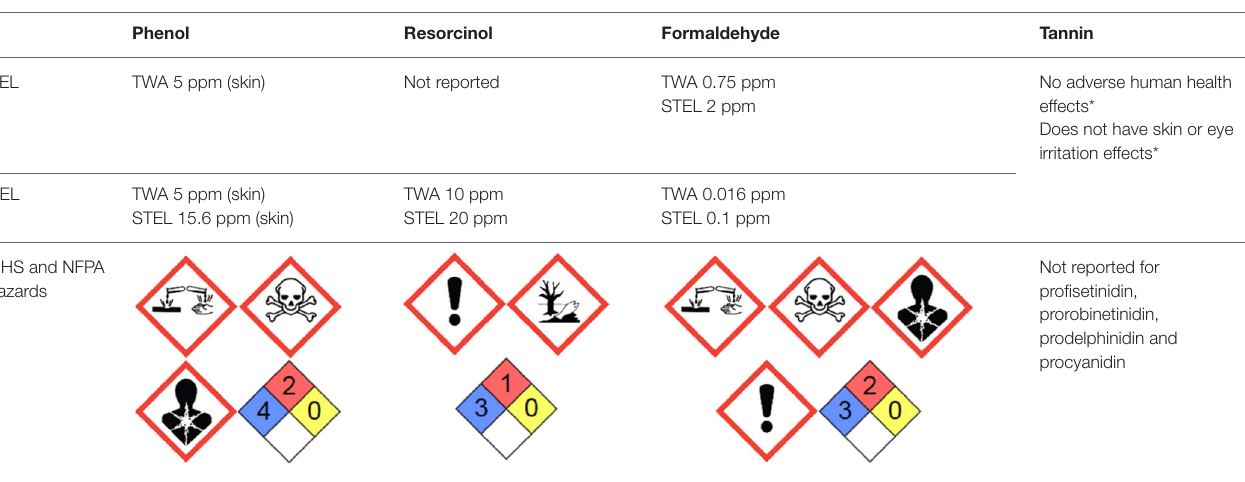
TABLE 2 | Hazard statements for phenol, resorcinol, formaldehyde, and tannin with data from the Kim et al. (2018) and the National Institute for Occupational Safety Health (2018).